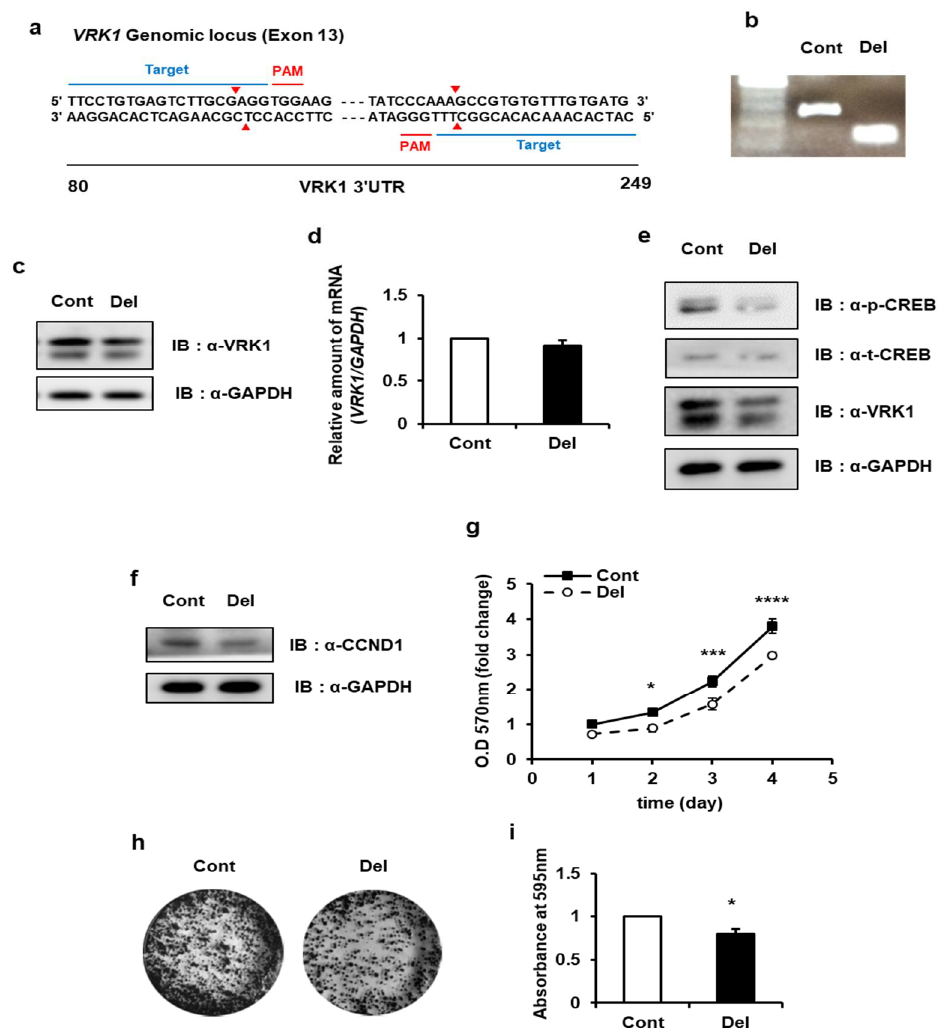
Figure 7. CRISPR/Cas9-mediated deletion of cis -acting element in VRK1 3 (cid:48) UTR suppresses lung cancer cells growth. ( a , b ) A deletion of cis -acting region in VRK1 3 (cid:48) UTR of lung cancer cell line was generated using the CRISPR/Cas9 system. The genome-edited cell line was selected by single cell sorting. Blue bars indicate the location of paired sgRNAs. Red arrowheads show expected deletion of the genomic DNA. Genotyping analysis identified an A549 cell line lacking the cis -acting region. ( c ) VRK1 protein expression was effectively decreased in the genome-edited cell line compared to the control. ( d ) qRT-PCR for VRK1 mRNA transcripts in the genome-edited cell line showed unchanged VRK1 mRNA levels. ( e , f ) p-CREB and CCND1 protein levels were decreased in cis -acting element deleted cells. ( g ) Cell proliferation was tested with MTT. Measurement of MTT conversion by absorbance at 570 nm showed that there was decreased proliferation with cis -acting region deleted cells (Two-way analysis of ANOVA with Sidak’s multiple comparisons, n = 4, * p < 0.05, *** p < 0.001, **** p < 0.0001). ( h , i ) Colony formation assays were performed in 6-well plates. Cells were grown for 10 days and were stained with crystal violet (left). Colonies were quantified by measuring the absorbance of extracted crystal violet at 595 nm (right) (Unpaired two-tailed t -test, n = 4, * p <